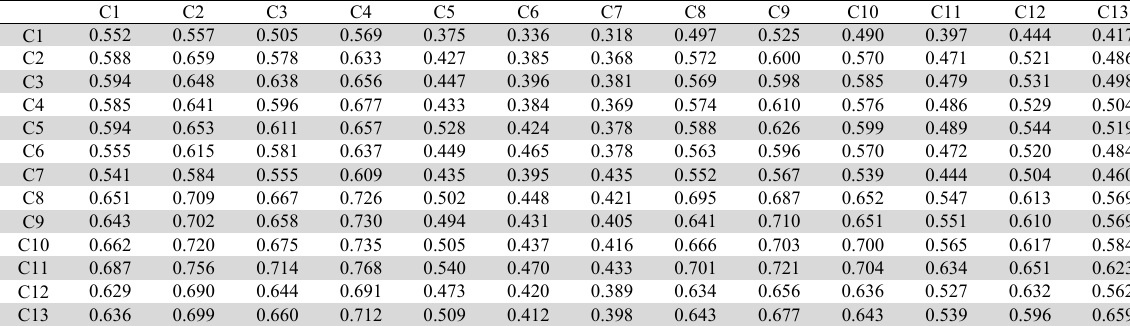
Total interrelationship matrix of criteria